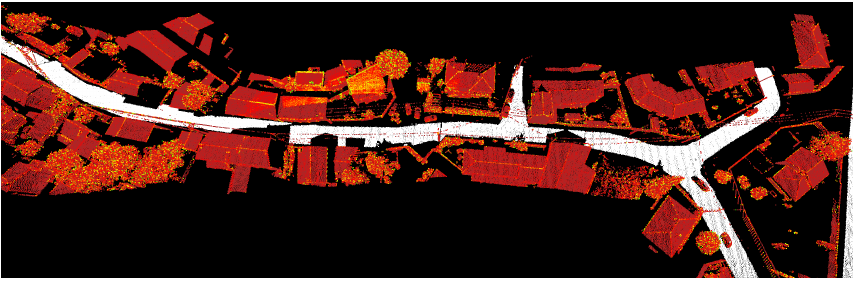
Figure 5. Distance to plane, KNN = 25. Vertical dispersion is a value that corresponds to the amount of noise in a local neighborhood along the Z axis (vertical axis). Vegetation areas have a tendency to be very unstable along the vertical axis, in contrast to urban areas. The example of this feature is presented in Figure 6.